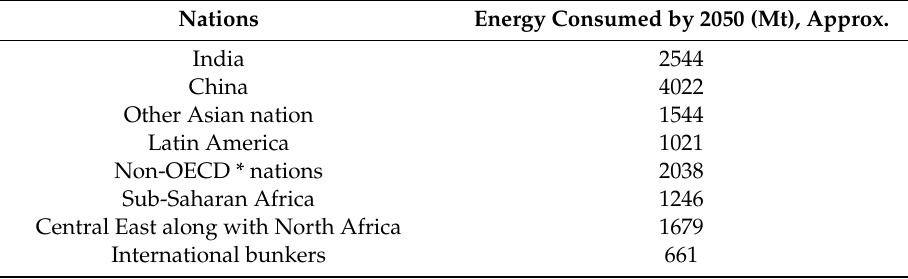
Table 2. World-wide consumption of primary energy by the year 2050 [9]. Nations Energy Consumed by 2050 (Mt), Approx.